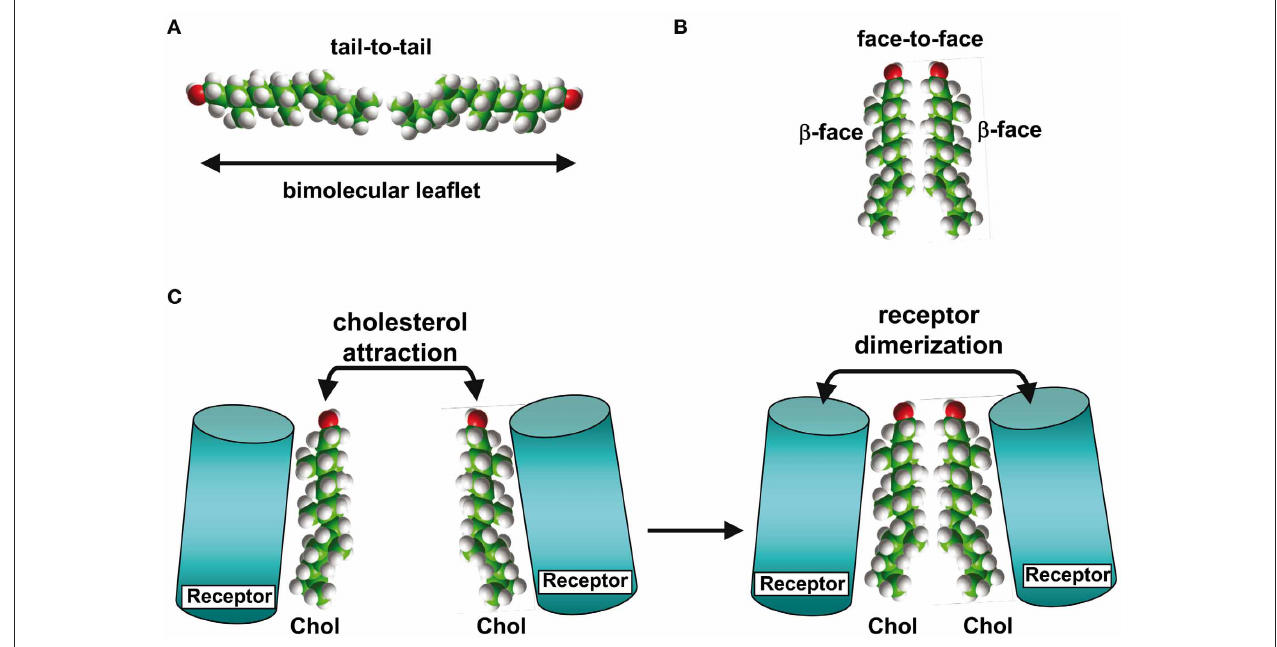
FIGURE 3 | Cholesterol-cholesterol interactions. In model membranes, two cholesterol molecules can form a tail-to-tail (A) or a face-to-face (B) complex. In the latter case, the self-recognition properties of